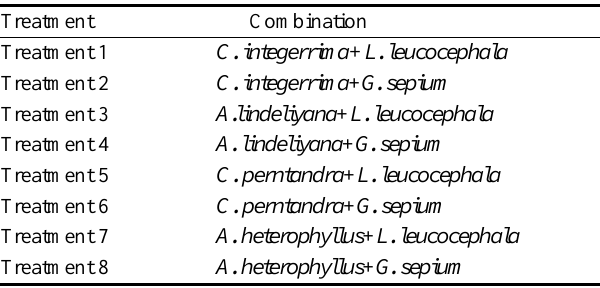
(1988). Two blank samples containing 30 ml of medium